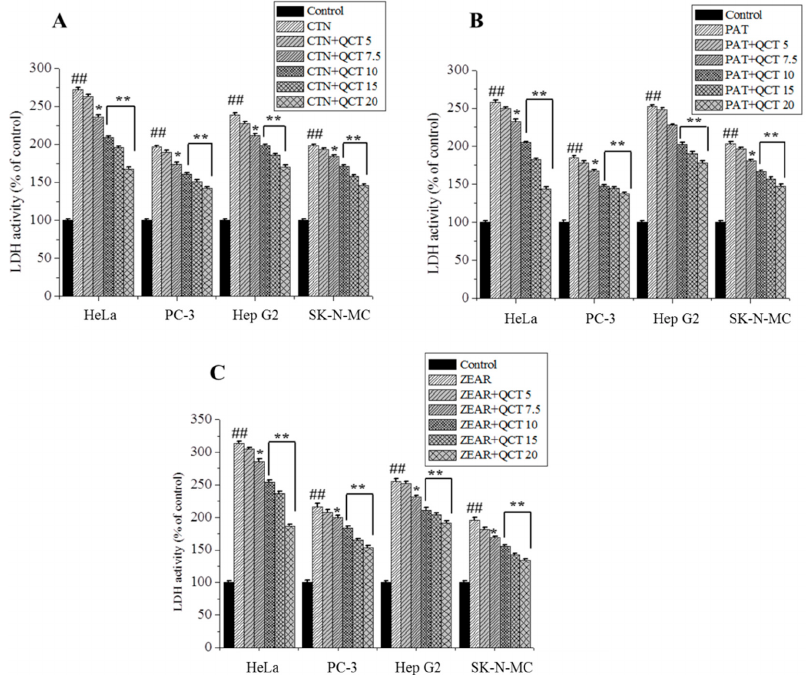
Figure 4. The protective effect of QCT against MTX-induced cytotoxicity. LDH activity on HeLa, PC-3, Hep G2, and SK-N-MC cells when pretreated with QCT and post-treated with various MTXs, such as ( A ) CTN, ( B ) PAT, and ( C ) ZEAR. Values were represented as mean ± SD. ## p < 0.01 as compared with the control group; * p < 0.05; ** p < 0.01 as compared with the MTX alone